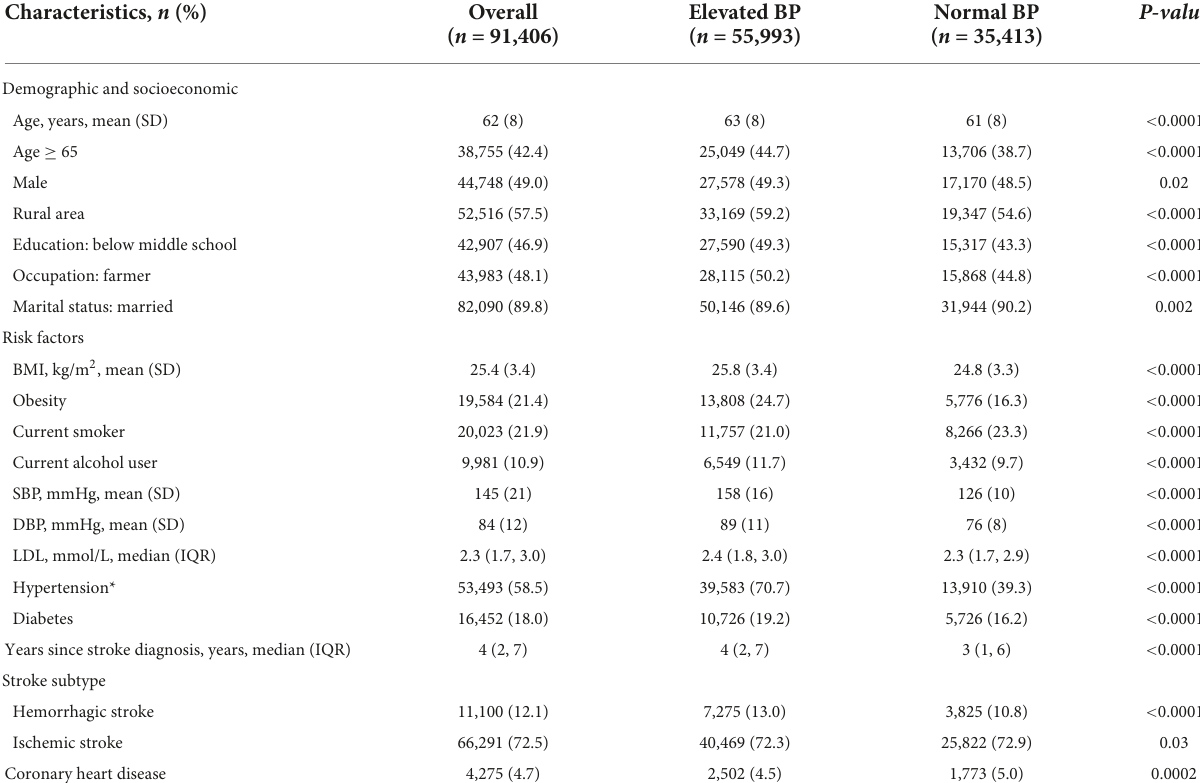
TABLE 1 Baseline characteristics of stroke survivors with elevated and normal blood pressure (BP).